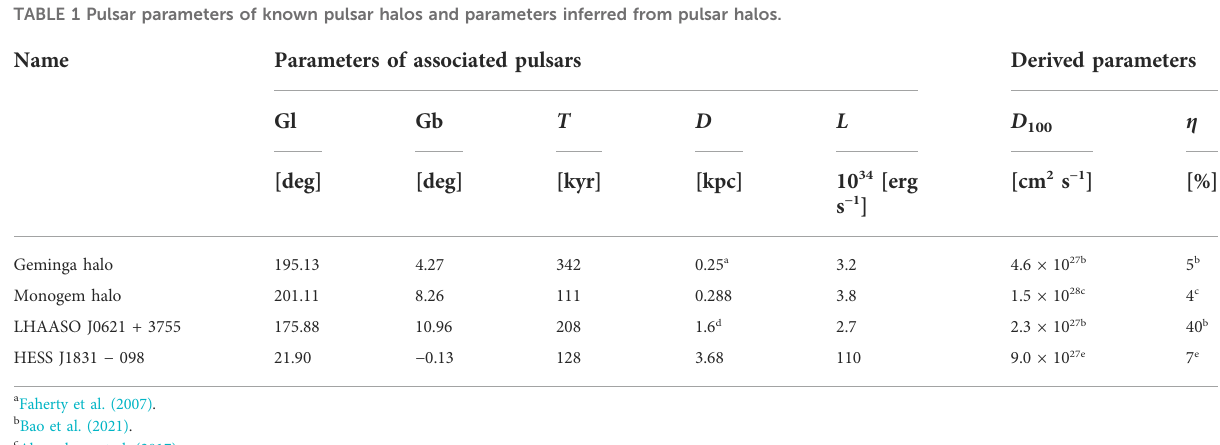
TABLE 1 Pulsar parameters of known pulsar halos and parameters inferred from pulsar